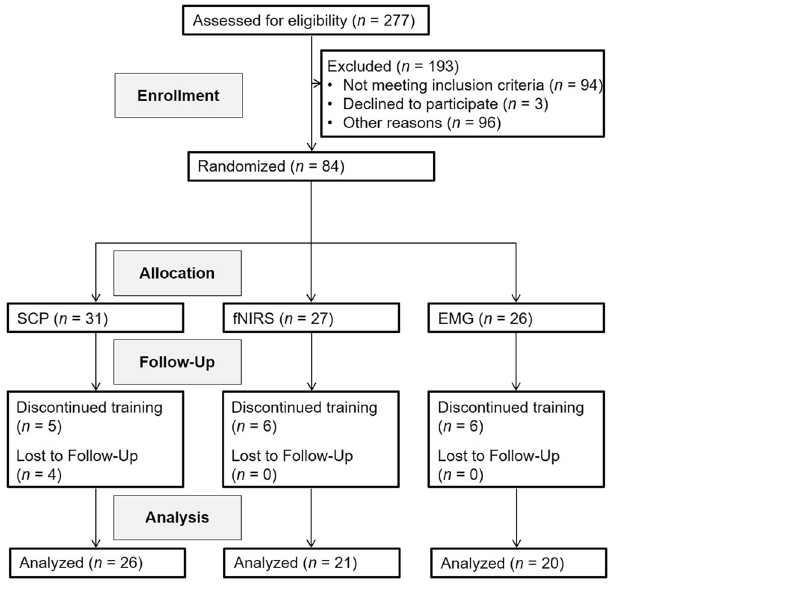
Figure 1. Diagram of participant